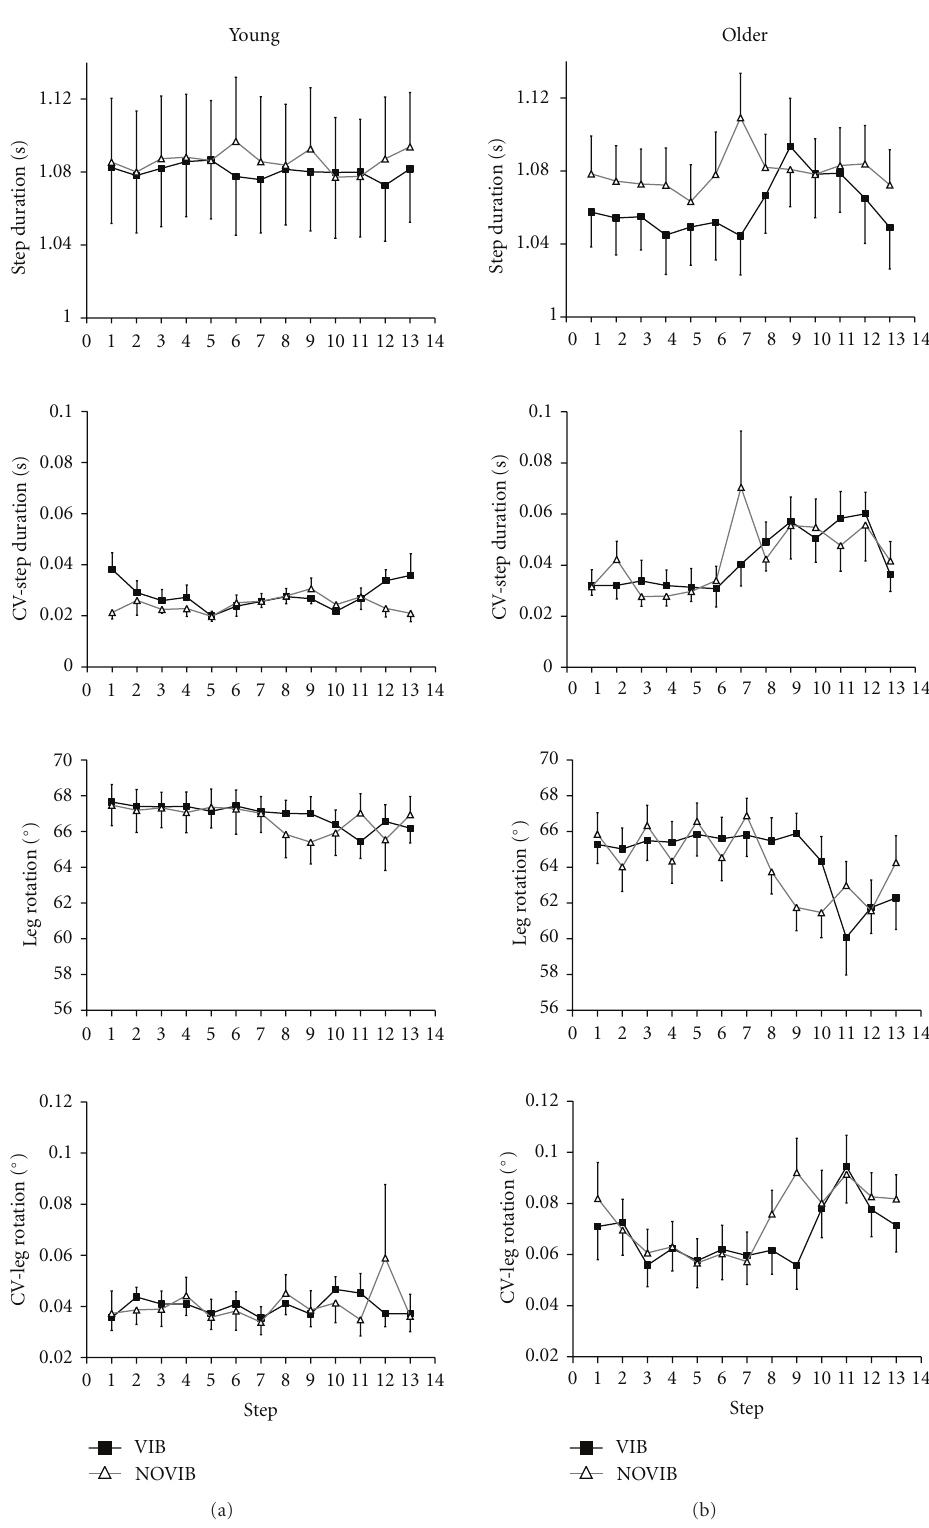
Figure 1: Gait parameters in young (a) and elderly subjects (b) during the last five steps before and the first eight steps after a distracter stimulus (dashed lines). Symbols represent across-subjects means and error bars the corresponding standard errors. Subjects walked without vibration (squares, black lines) as well as with vibration of the pronator and supinator muscle tendons of both feet (triangles, gray